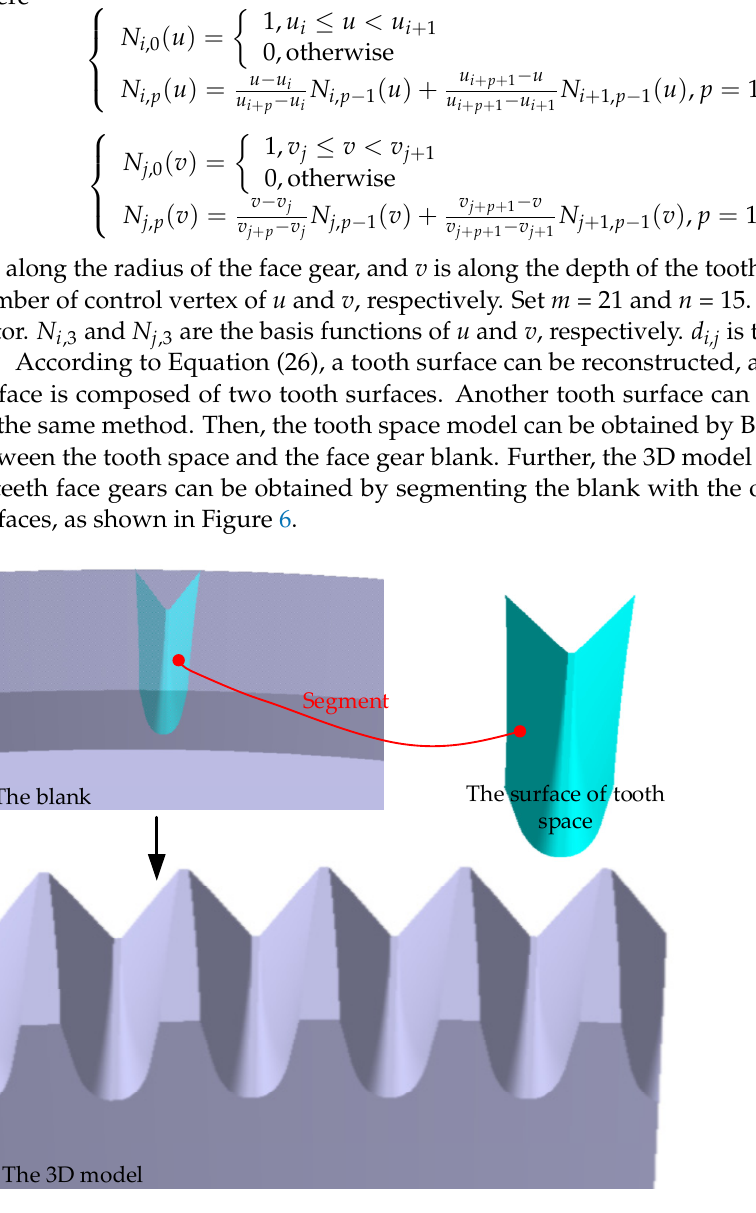
Figure 6. A 3D model of real five-pairs-of-teeth face gear.